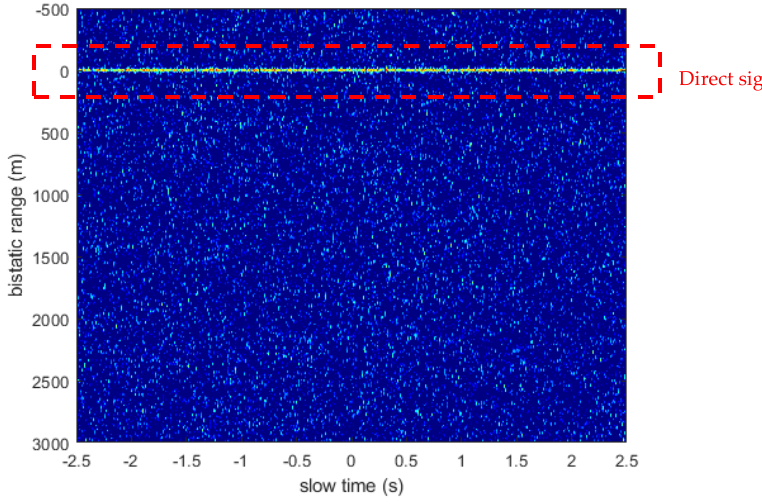
Figure 11. Range-compressed data of satellite C41.